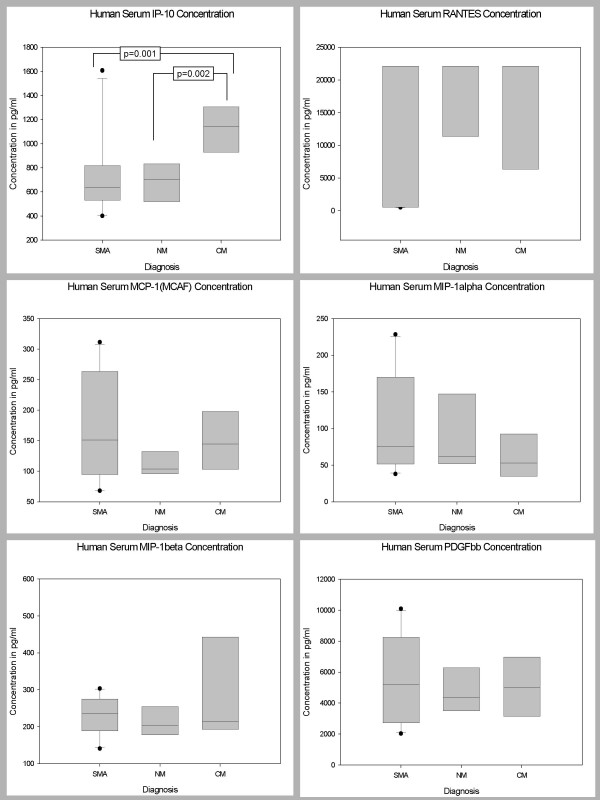
Postmortem serum biomarker levels of IP-10, RANTES, MCP-1, MIP-1α, MIP-1β, and PDGFbb in children dying with CM, SMA, NM causes. CM, cerebral malaria; SMA, severe malarial anemia; NM, non-malaria. Box plots representing medians with 25th and 75th percentiles, bars for 10th and 90th percentiles, and points for outliers of biomarker concentrations. Only statistically significant P values after Bonferroni adjustment for the other biomarkers are shown.